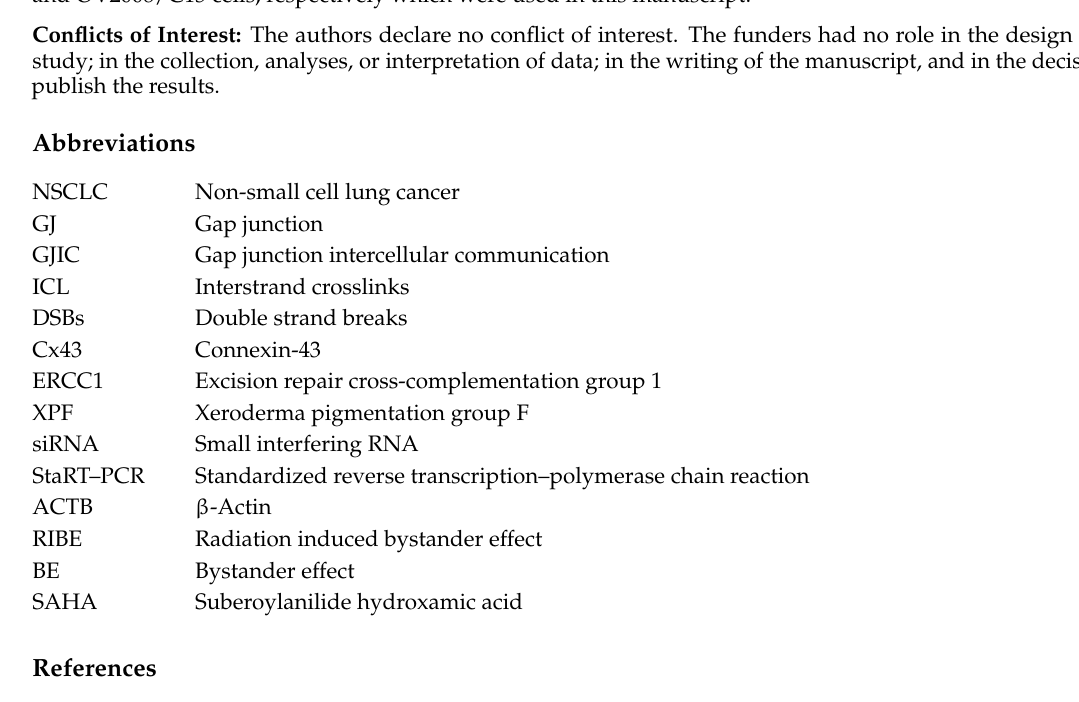
survival, Figure S3: Cx43 expression, knockdown time course and dye transfer test, Figure S4: Immunofluorescence with cisplatin-intrastrand adduct specific